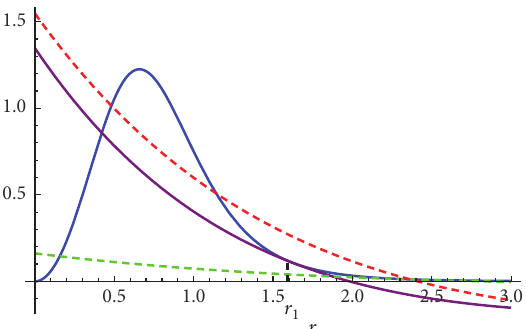
Figure 13: Sketches of 𝑓 󸀠 (𝑟) (blue) and 𝑔 󸀠 (𝑟) = 𝑐 1 (1 + 𝑐 2 𝑟) exp (𝑐 2 𝑟) (purple). The dashed red curve and the dashed green curve represent ̃𝑐 ̃𝑔 󸀠 (𝑟) = ̃𝑐 (1 + ̃𝑐 𝑟) exp (̃𝑐 𝑟) with ̃𝑐 > 𝑐 < 𝑐 1 2 2 1 1 and 1 1 ,